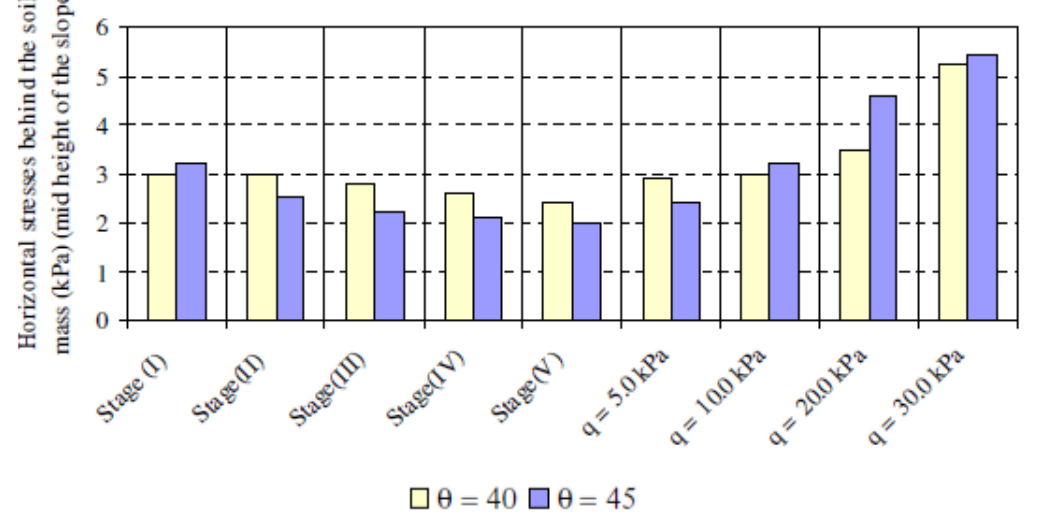
Figure 17. Influence of slope inclination on horizontal stresses behind the nailed soil mass at mid-height of slope.